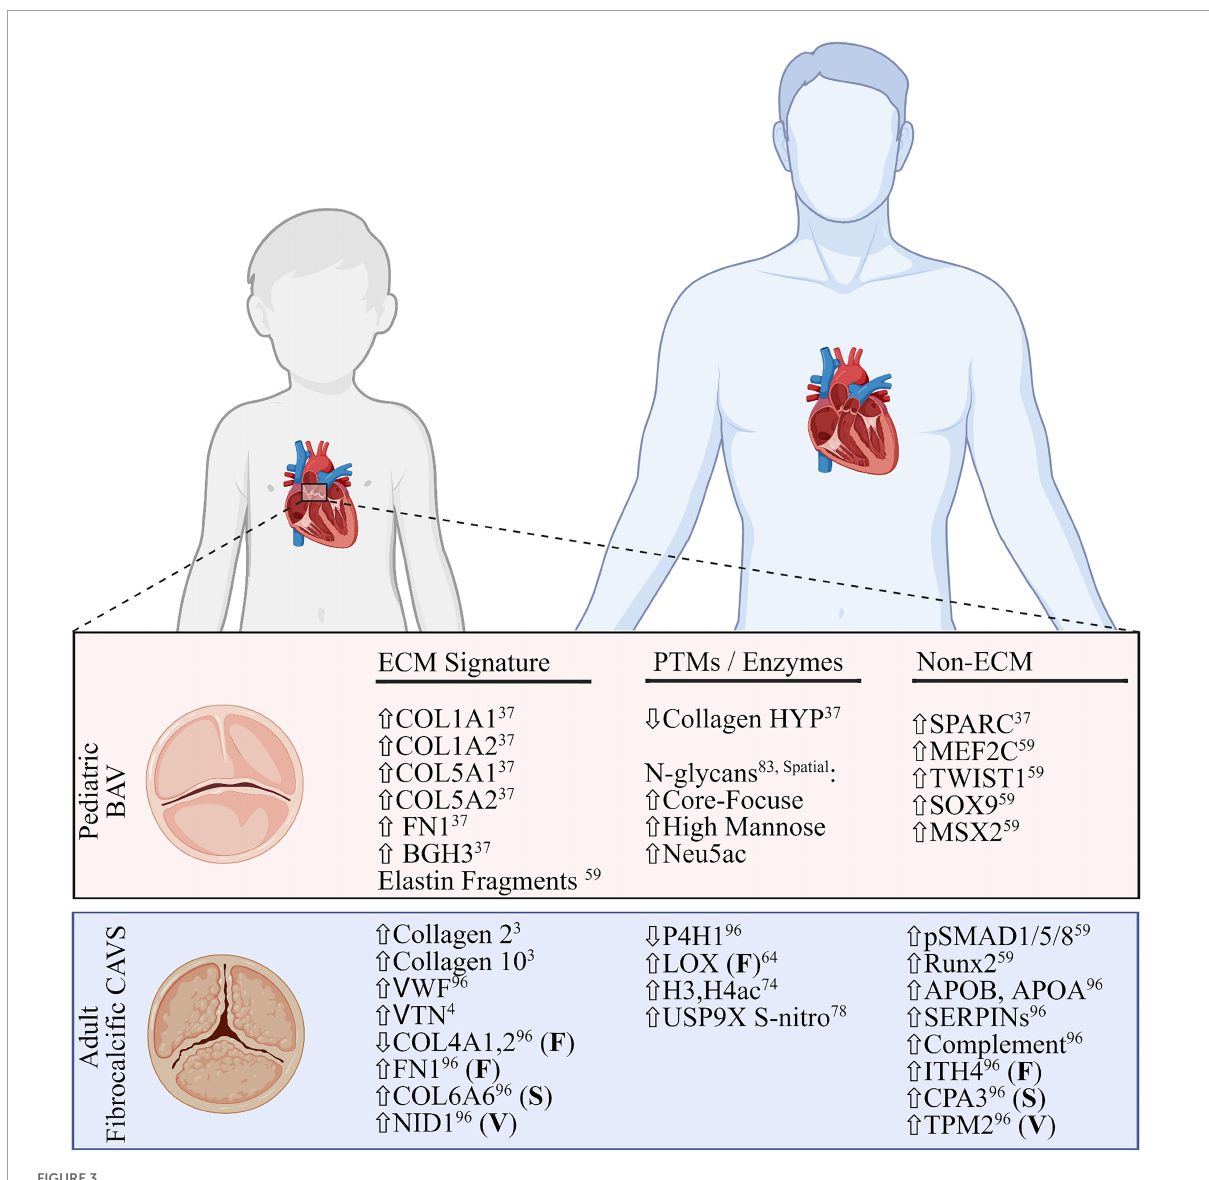
FIGURE3 Comparative summary of transcriptomic and proteomic profiles of pediatric bicuspid aortic valve disease and adult fibrocalcific CAVS. Extracellular matrix (ECM) signatures (left) , post-translational modifications or related enzymes (middle) and non-ECM/PTM signatures (right) are shown. All signatures are described as global changes unless otherwise specified (F, fibrosa; S, spongiosa; V, ventricularis). For the purposes of this review, the top layer-specific alteration is shown. FN1, fibronectin; BGH3, TGFB induced protein ig-h3; MEF2C, myocycte-specific enhancer factor 2C; TWIST1, twist-related protein 1; MSX2, homobox protein MSX2. VWF, Von Willebrand Factor; VTN, vitronectin; NID1, nidogen-1; P4H1, prolyl-4 hydroxylase-1; LOX, lipoxygenase; H3,H4, histone3,4; USP9X, ubiquitin carboxyl-terminal hydrolase FAF-X;